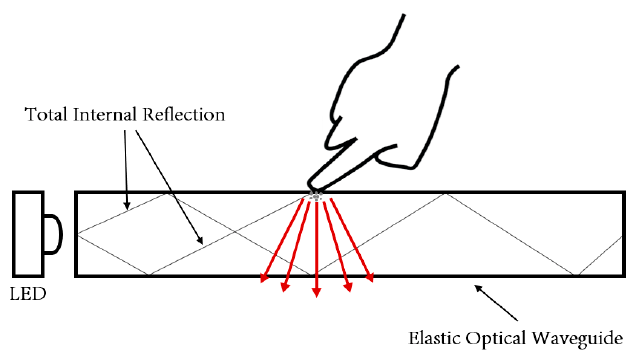
Figure 13. Tactility concept using the TIR principle.